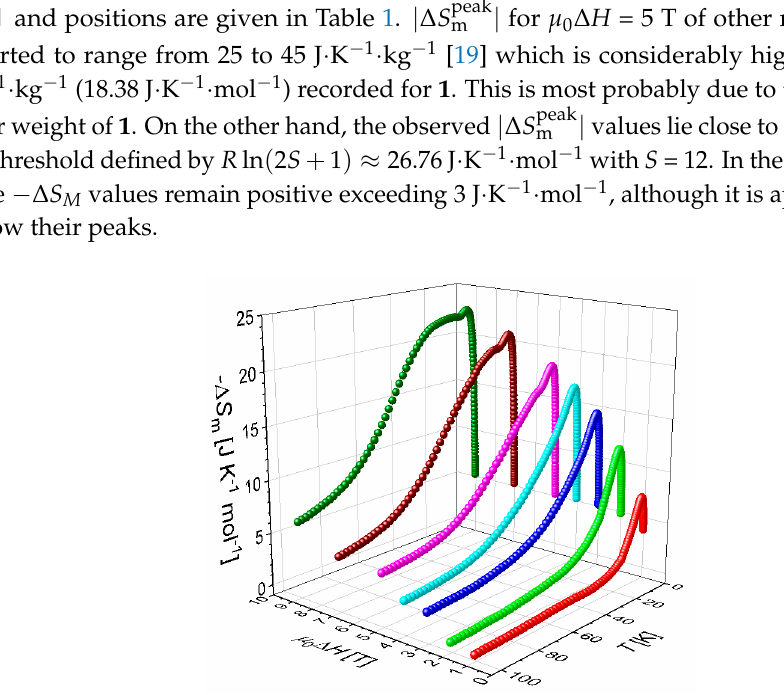
Figure 5. Isothermal entropy change Δ S m as a function of temperature for 1 (symbols) inferred from the calorimetric data. Table 1. Peak values of Δ S m and Δ T ad of 1 .